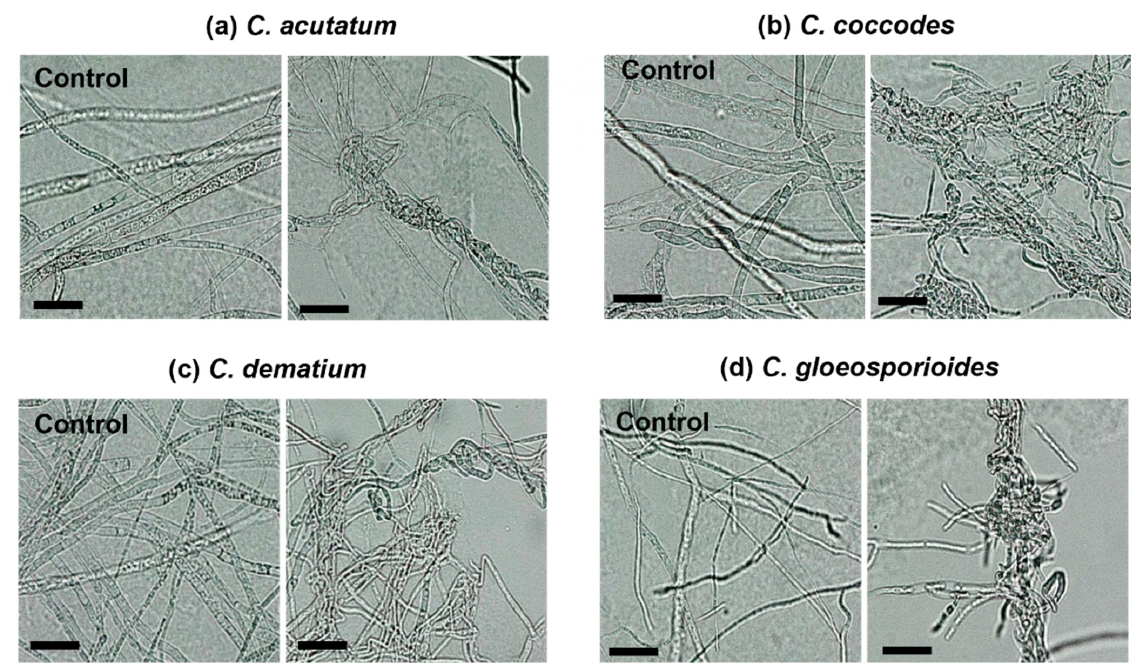
Figure 4. Morphology of VOC-affected hyphae of C. acutatum ( a ), C. coccodes ( b ), C. dematium ( c ), and C. gloeosporioides ( d ) compared with morphology of the controls. (scale bar = 25 μ